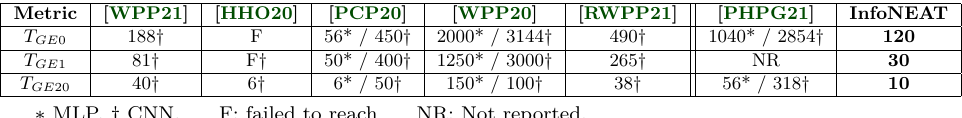
Table 3: Comparison between InfoNEAT and SOTA attacks against ASCAD var dataset. Metric